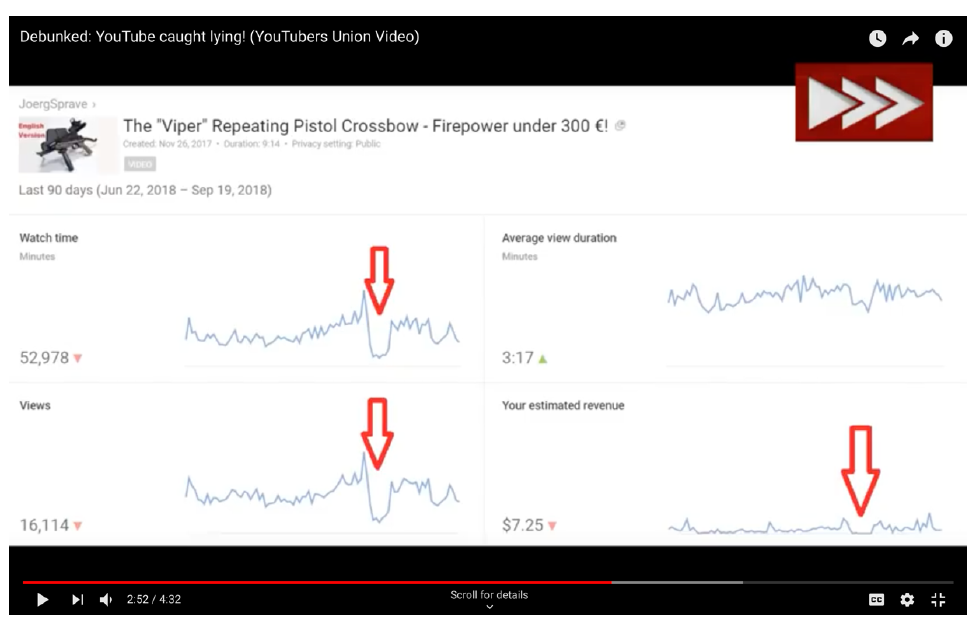
Figure 4: Screenshot from Sprave’s video showing the perfect synchronisation between viewership (two graphs on the left) and the monetisation status of his video (bottom right